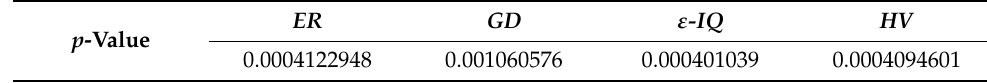
Table 6. p -values returned by the Wilcoxon Rank Sum